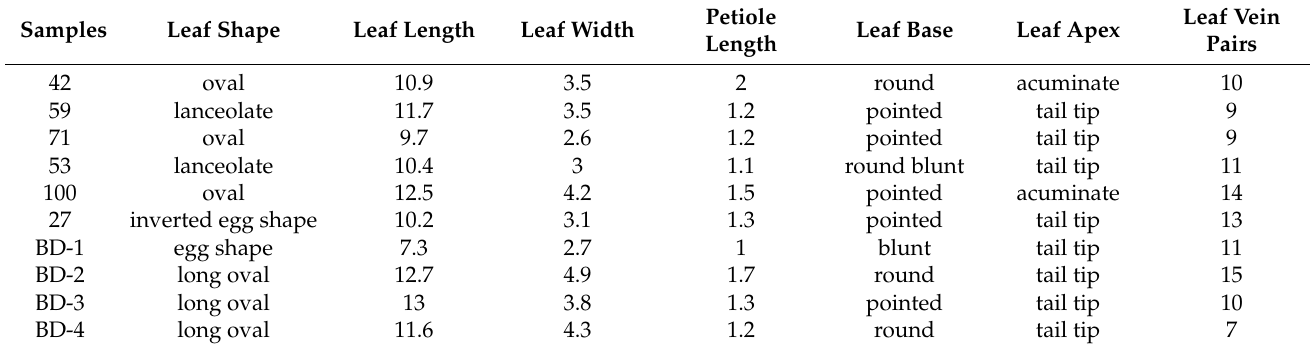
Table 1. Differences in leaf traits of selected durian